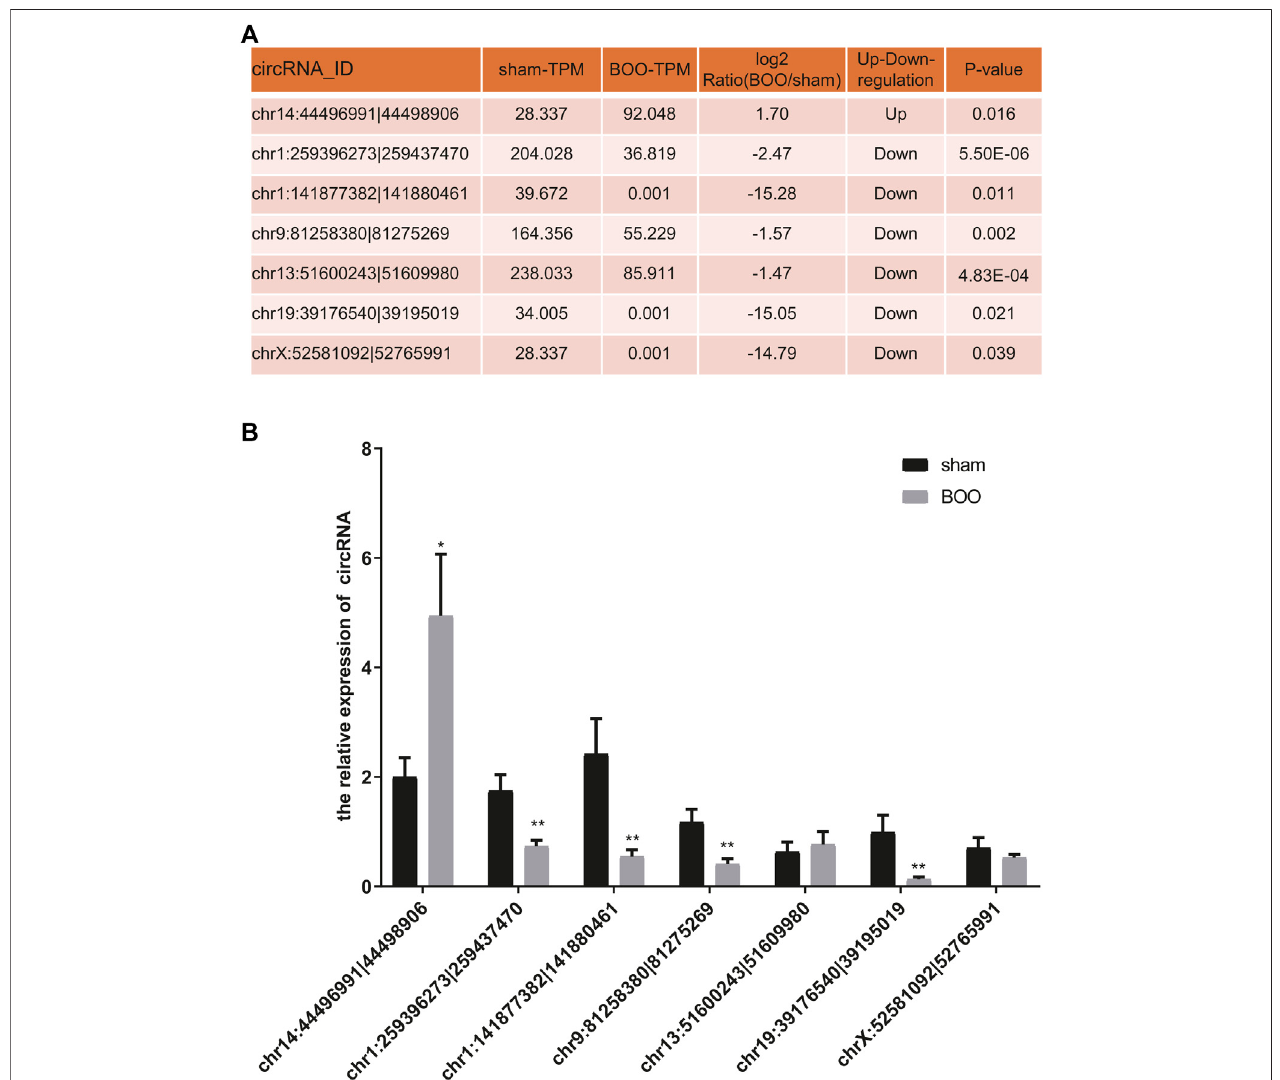
FIGURE 3 | Validation of protein-encoding circRNA expression in rat BOO model. (A) The list of predicted protein-encoding circRNAs selected for validation and their expressional alterations in rat BOO model shown by RNA sequencing. The expressional ratio between the Sham and BOO groups, as well as the statistical signi fi cances( p values),duringtheRNAsequencingwereshowninthetable. (B) Relativeexpressional levelsofrepresentativeprotein-encodingcircRNAsintheratBOO model. The expression of circRNAs in rat BOO model ( n (cid:2) 7) were measured by quantitative RT-PCR method, compared with the Sham group ( n (cid:2) 8). * p < 0.05; ** p < 0.01. Error bar indicated standard error. Mann-Whitney U test was used for comparison between groups.